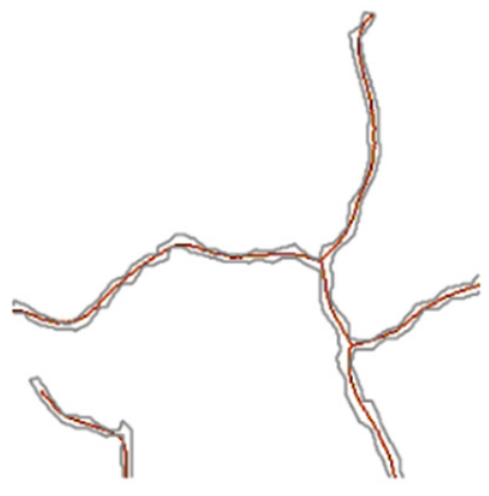
Figure 8. Crack skeletonization.